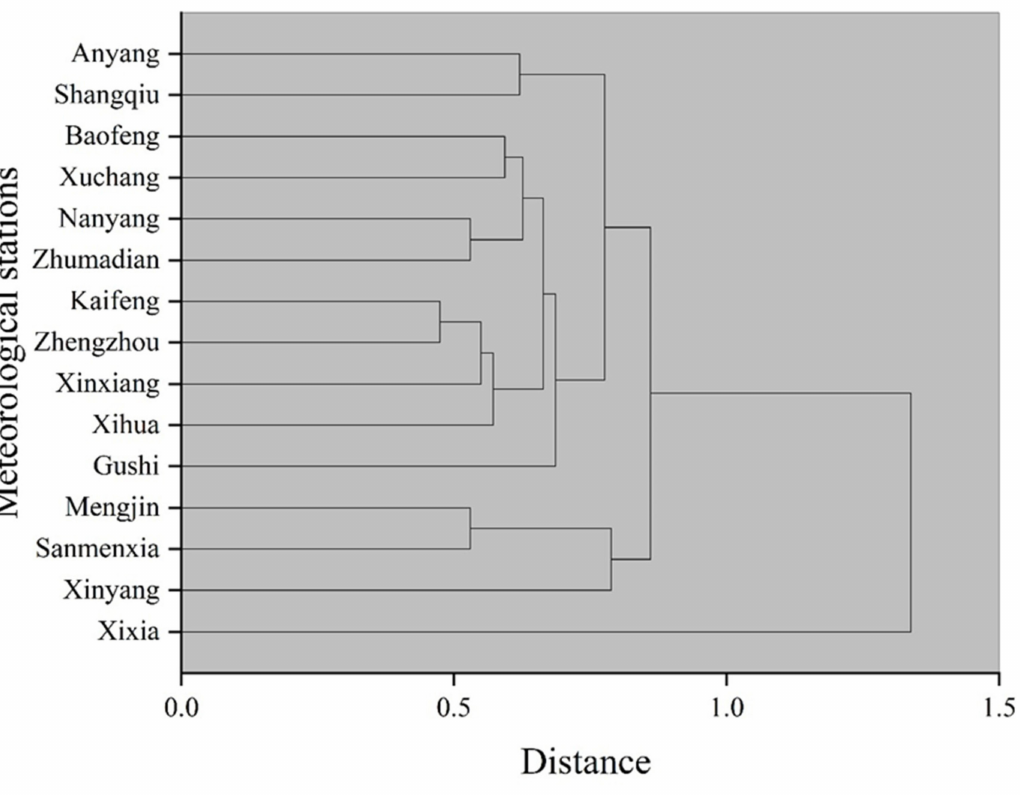
Figure 7. Hierarchical clustering of the TCCI at various meteorological stations in Henan